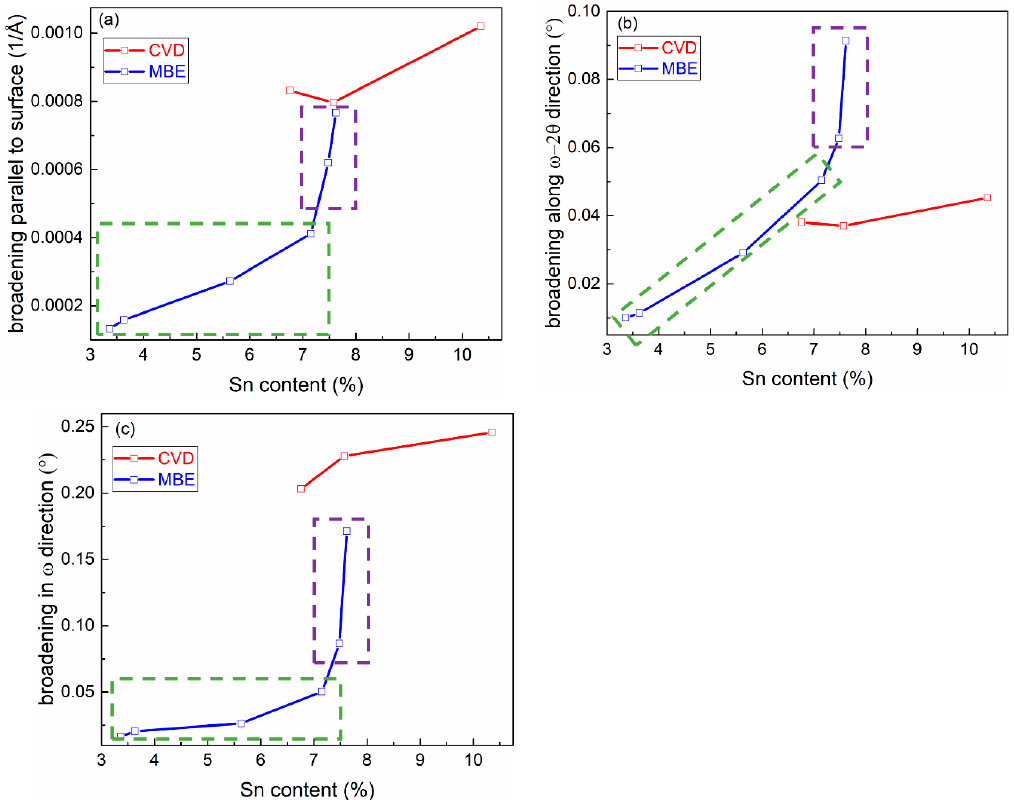
Figure 3. The broadening of the GeSn epilayer features parallel to the surface ( a ), along the ω - 2 θ direction ( b ) and in the ω direction ( c ). The red and blue curves represent the samples grown by CVD and MBE, respectively. The green and purple dotted square frame marked samples M1-M4 and M5-M6, of which the GeSn layers are fully strained and partially relaxed to Ge substrate, respectively. The CVD grown samples C1-C3 are almost fully relaxed to Ge-VS.